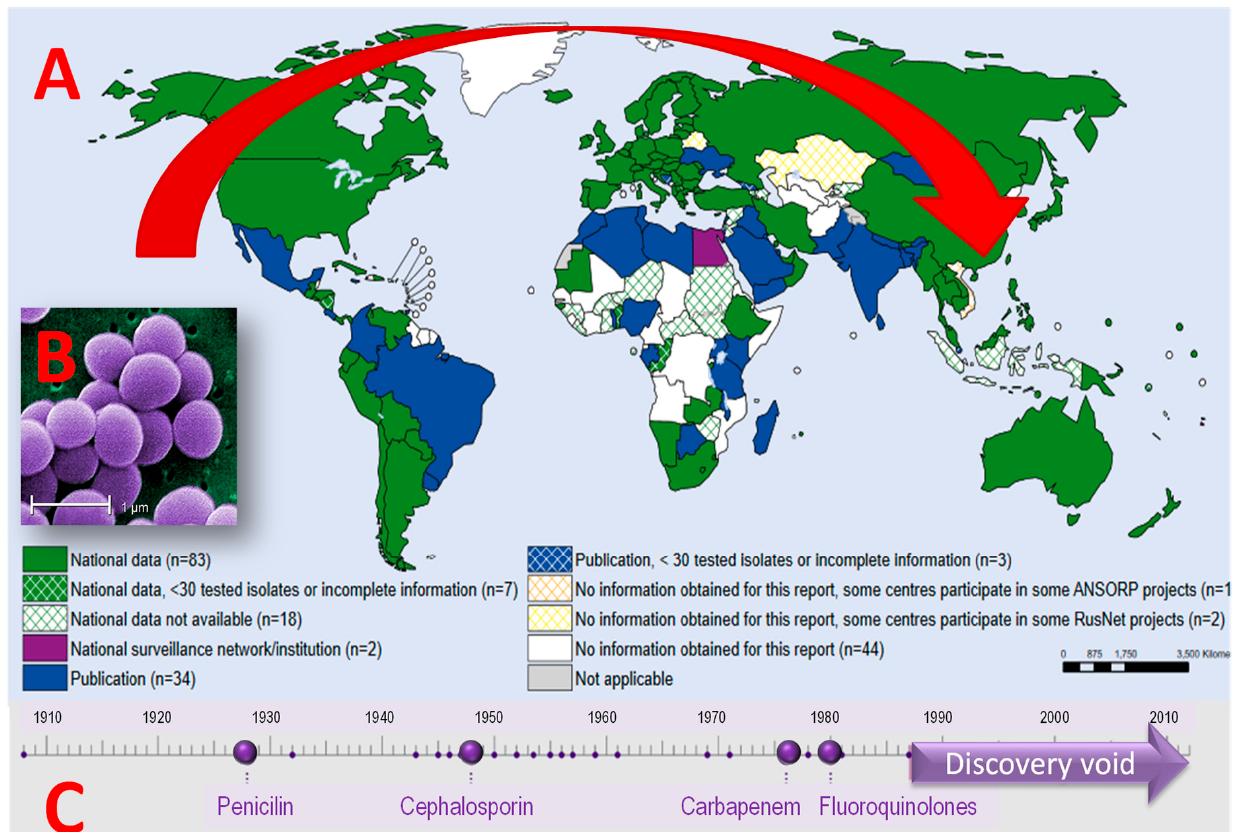
Figure 2. ( A ) Collected data on the number of infections by S. Aureus (MRSA), WHO 2014; ( B ) SEM microphotographs of Staphylococcus aureus [13]; ( C ) discovery void in new antibacterial drugs during the last 30 years.